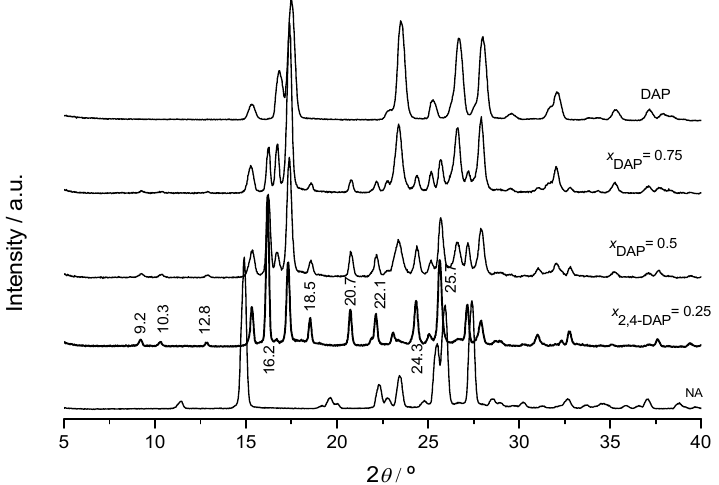
Figure 3. XRP diffractogram of DAP+NA mixtures of different compositions, obtained by LAG, ethanol-assisted.